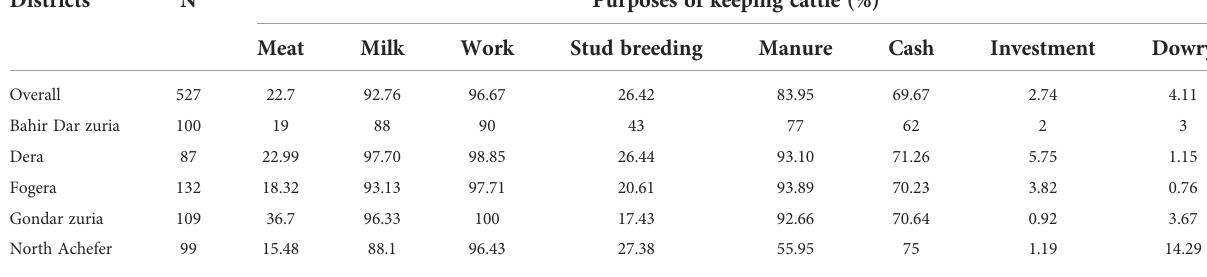
TABLE 4 Weighted proportion for the breeding objectives of cattle in the study area. Districts N Purposes of keeping cattle (%)